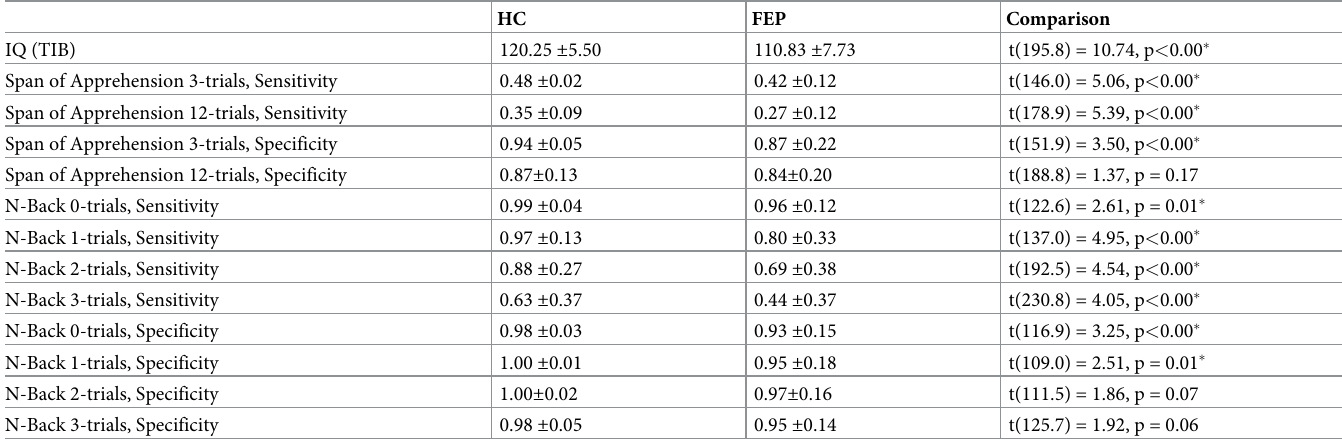
Table 6. Cognitive and neuropsychological data in FEP and